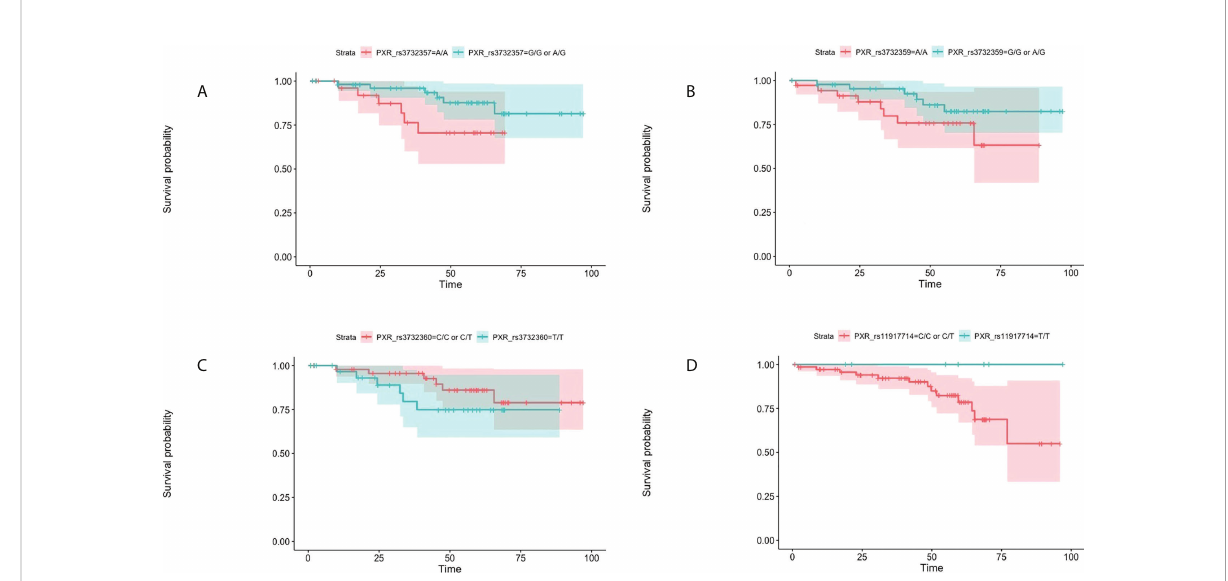
FIGURE 2 Kaplan-Meier plots for progression- free survival in regard to the presence of rs3732357 (A) , rs3732359 (B) , rs3732360 (C) , and rs11917714 (D) in the PXR gene in the co-dominant inheritance